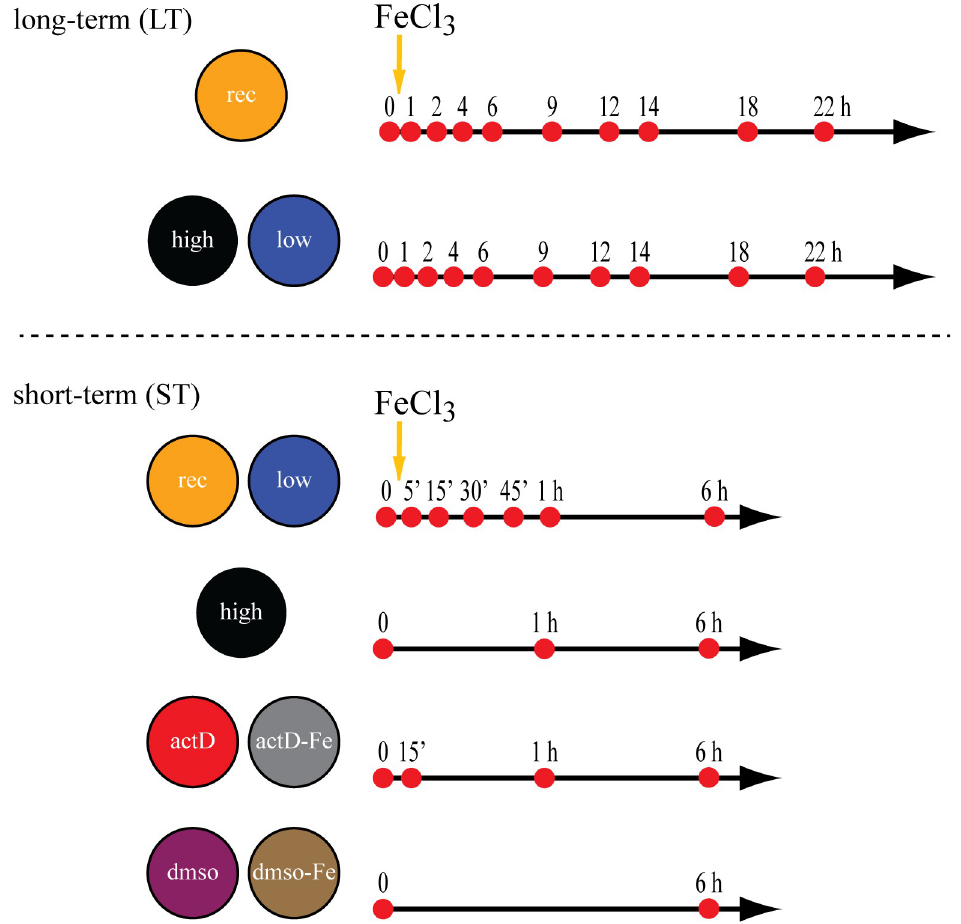
Fig 1. Overview of sampling times in the short-term and the long-term experiment. Overview of the sampling time points conducted during the long-term (LT) and the short-term (ST) experiment. The different treatments are indicated on the left, with the sampling times in hours (h) to the right. Orange arrows indicate the addition of iron with only the iron-recovery (rec), the actD-Fe and the dmso-Fe samples receiving 10 μ M final concentration FeCl 3 immediately after the initial measurement T 0